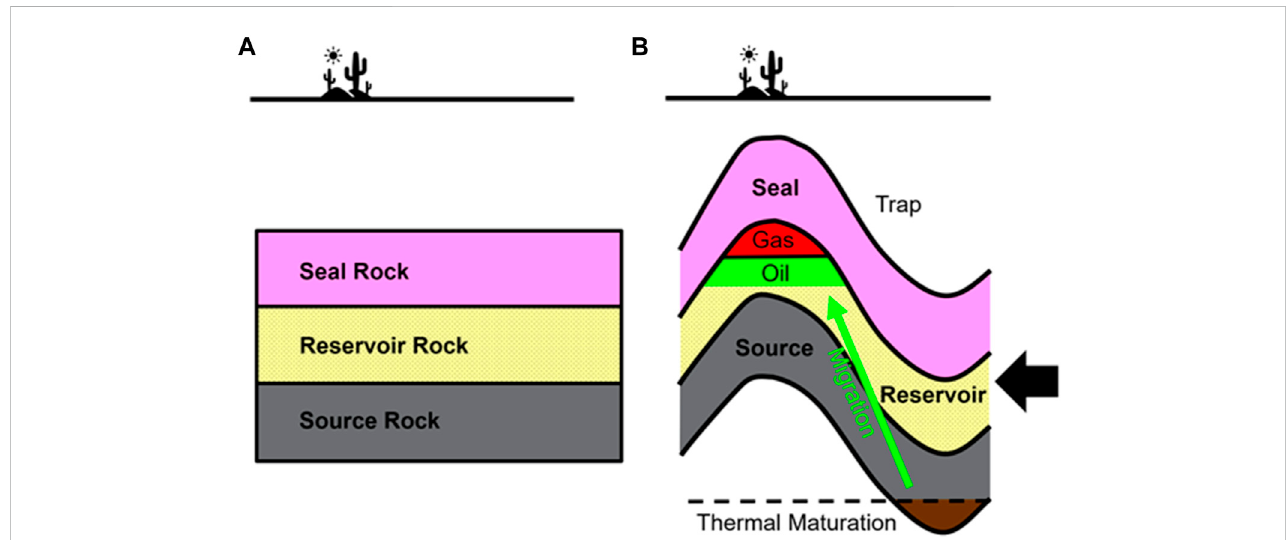
FIGURE 2 Simpli fi ed illustration of the key elements of a successful petroleum system. (A) . Deposition of source, reservoir, and seal rocks. (B) . Folding creates a petroleum trap. A migration pathway must exist to fi ll a trap with oil and/or